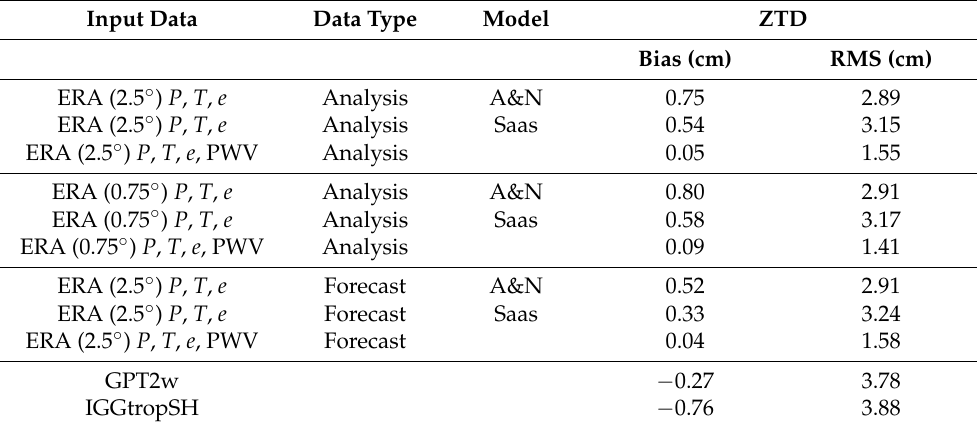
Table 6. Statistics of global mean accuracies of ZTDs calculated from ERA surface data and two empirical tropospheric models, GPT2w and IGGtropSH, with GNSS-ZTDs over 302 IGS stations during 2015 as references.